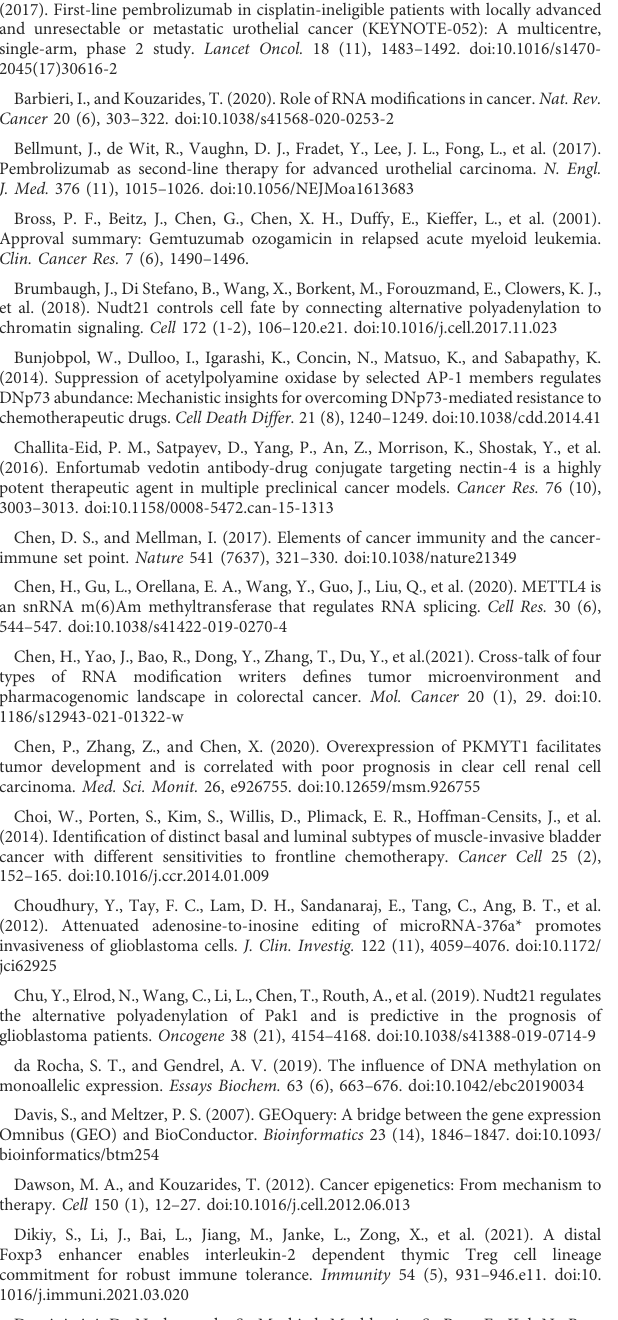
SUPPLEMENTARY FIGURE S4 Pan-cancer analysis of RMS model-associated genes. (A) Dot chart showing RMS model-associated genes whose mRNA expression was signi fi cantly correlated with CNV percentage. Blue and red bubbles represented a negative or positive correlation between mRNA expression and CNV. The color and size bubble illustrated the degree of correlation and the statistical signi fi cance,respectively. (B) Piediagramillustratingproportionofdifferent types of CNV of RMS model-associated genes in multiple tumors. (C) Dot chart representing mRNA differential expression analysis of 14 RMS model-